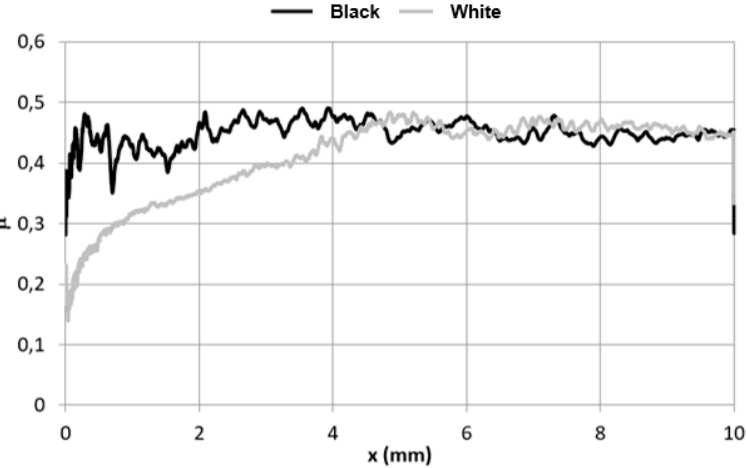
Figure 5. Average friction coefficient ( µ ) courses in the scratch test.